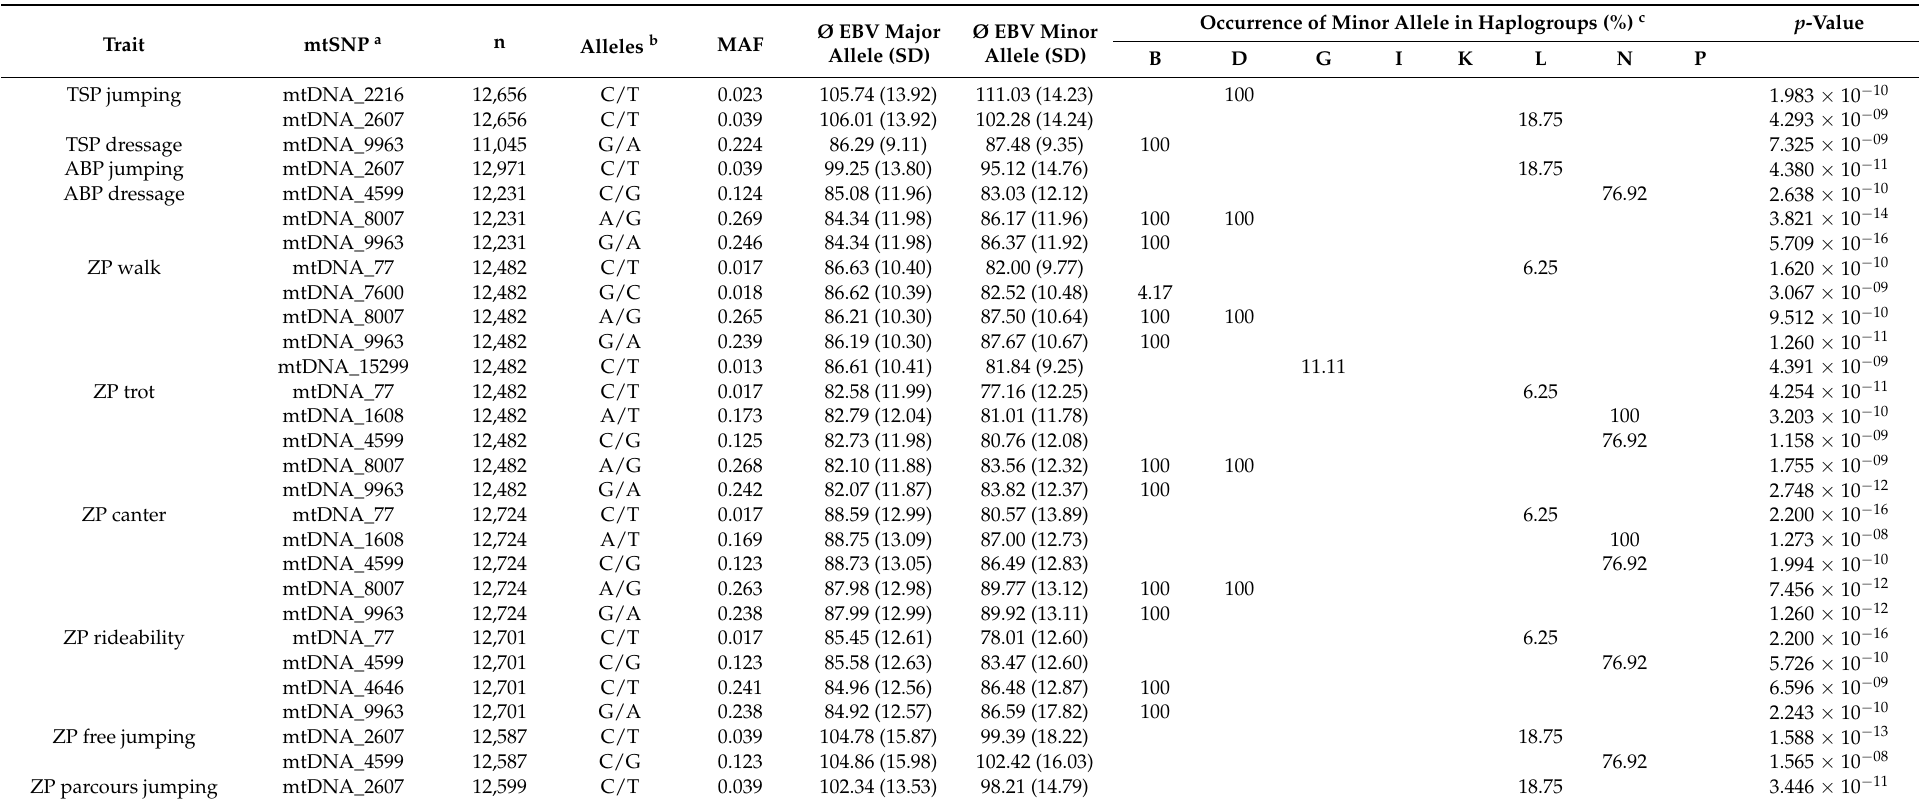
Table A1. Results for the association between FN breeding values (EBV) and significant mitochondrial SNPs (p < 5 x 10 − 8 ), average breeding values for the two alleles, and distribution of the minor allele among